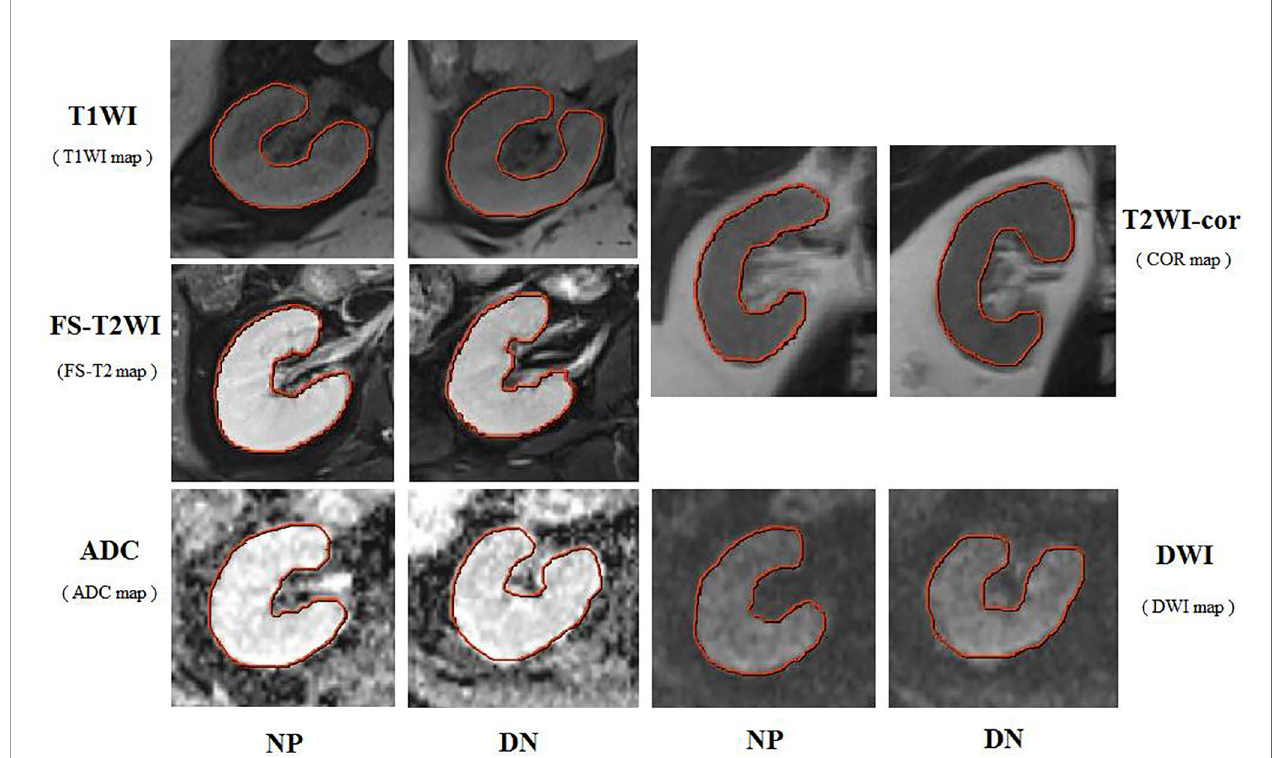
FIGURE 2 | Respective MRI images of the right kidney with stage III type 2 DN and normal persons (NP). The ROI were curved over the renal parenchyma of the right kidney (red curve). In this study, the images analyzed were the T1WI maps, FS-T2WI and T2WI-cor maps, DWI and ADC